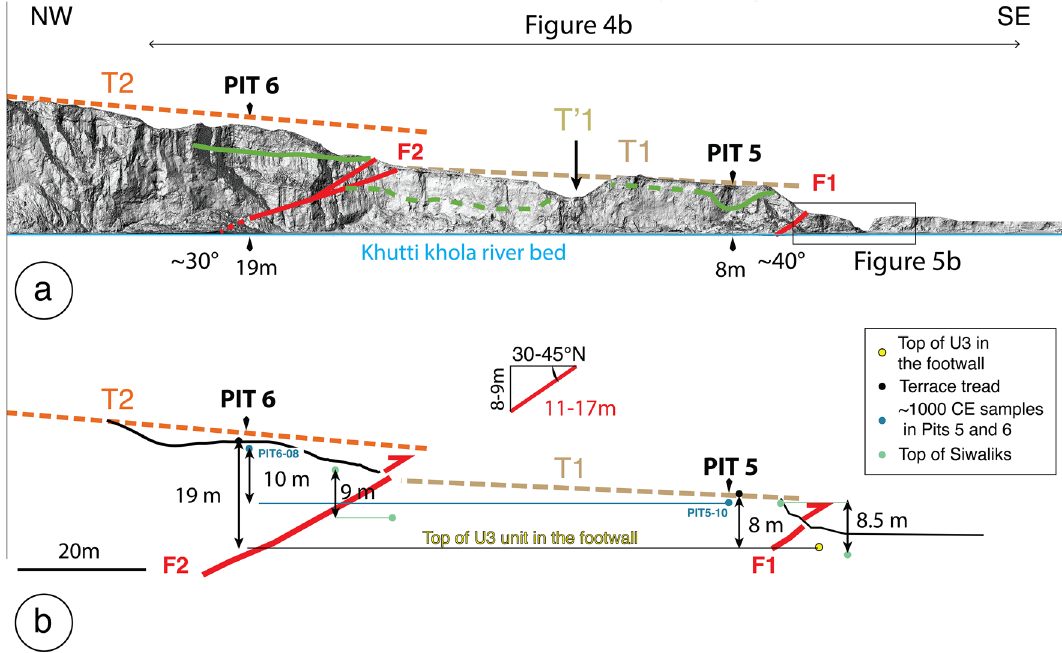
Figure 7. Interpretative section of the Khutti Khola rivercut and coseismic slip. ( a ) Lidar acquired Digital Surface Model of the rivercut. Green lines represent the top of the Siwalik, the black box locates the trench site. ( b ) Schematic